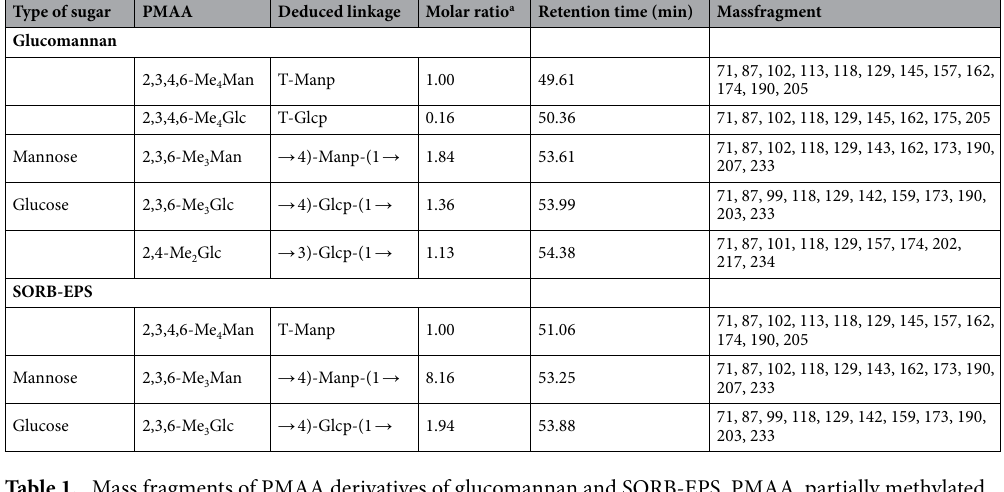
Table 1. Mass fragments of PMAA derivatives of glucomannan and SORB-EPS. PMAA, partially methylated alditol acetate. a Molar ratios relative to the 3-linked-glucoseand 4-linked-mannose